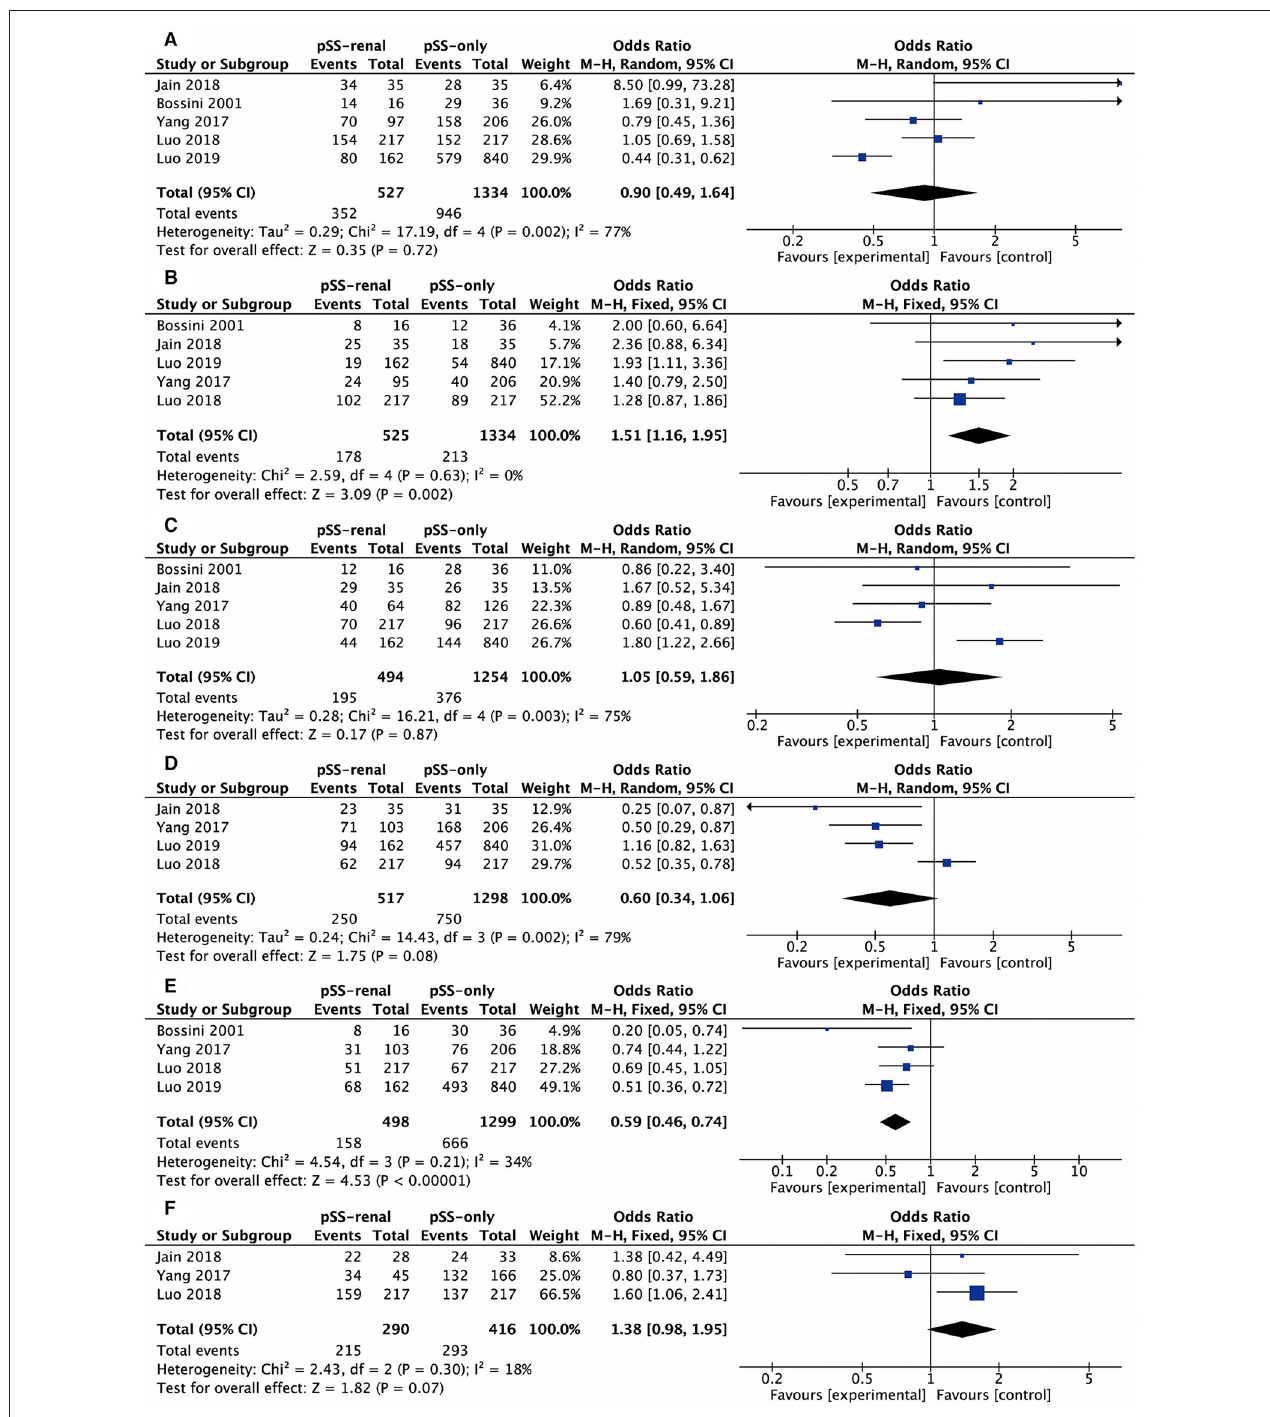
FIGURE 2 | Forest plots of relevant factors of renal involvement in primary Sjögren’s syndrome. (A) Anti-SSA antibody; (B) anti-SSB antibody; (C) rheumatoid factor; (D) dry eyes; (E) arthralgia; (F) labial salivary gland